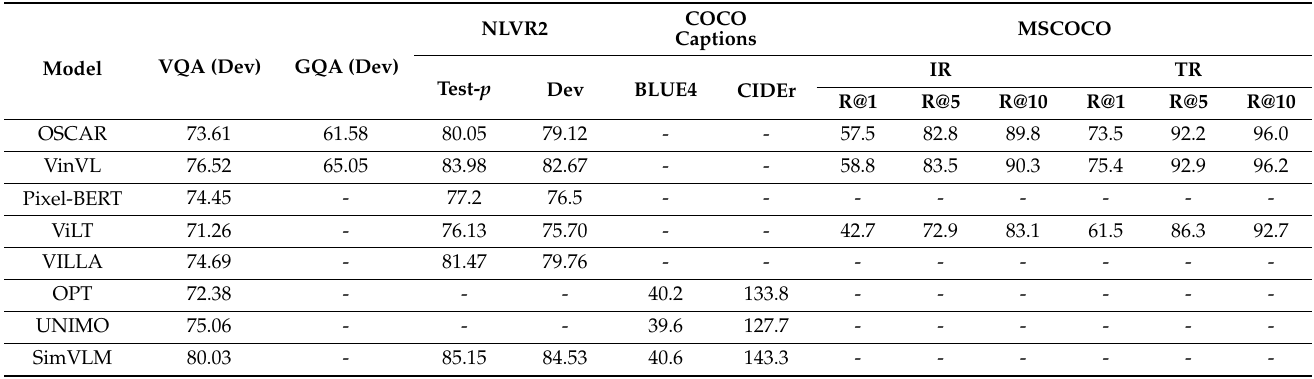
Table 6. Comparison of results of single-stream architecture image–language pretraining models on selected datasets.